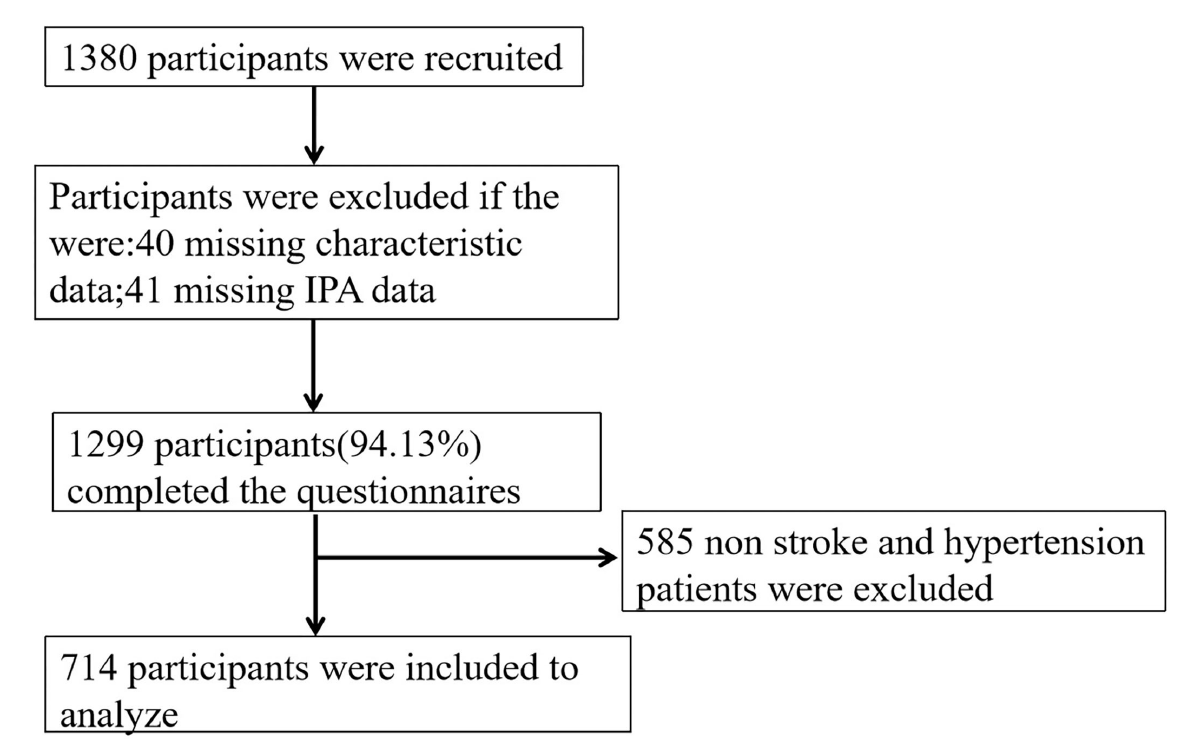
FIGURE1 Flowchart on participant